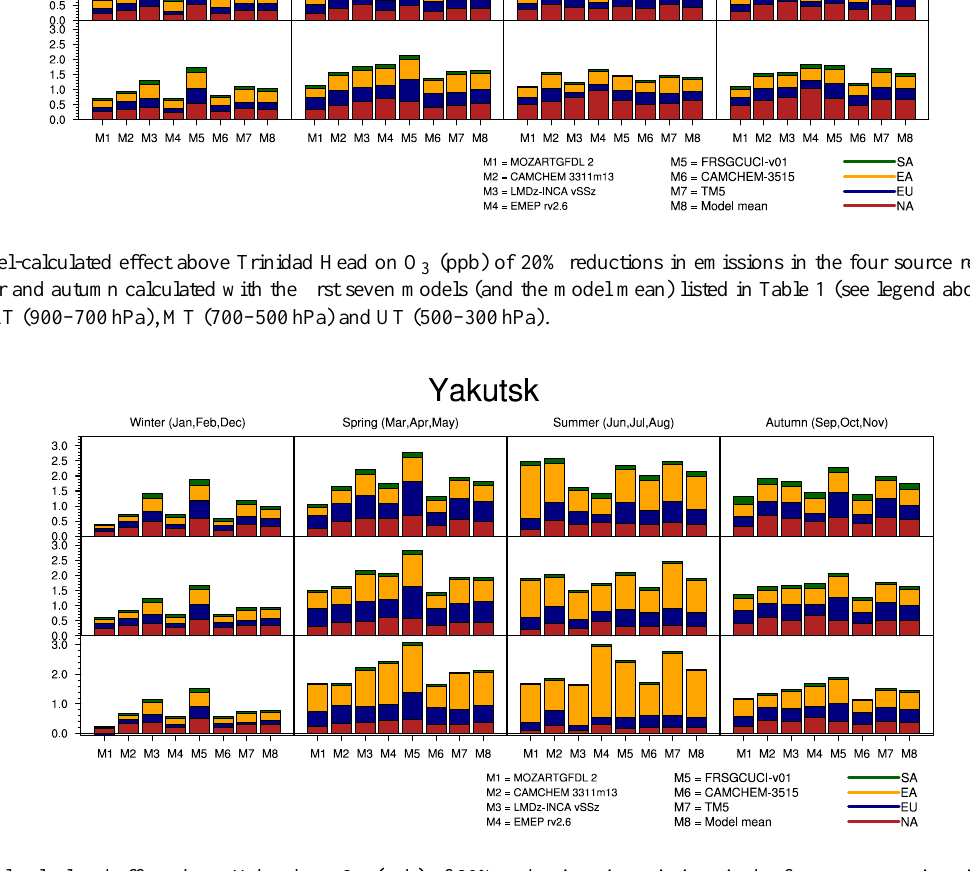
Fig. 20: Model-calculated effect above Yakutsk on O 3 (ppb) of 20% reductions in emissions in the four source regions in winter, spring, summer and autumn calculated with the first seven models (and the model mean) listed in Table 1 (see legend above). Results are aggregated to LT (900 - 700hPa), MT (700 - 500hPa) and UT (500 - 300hPa).